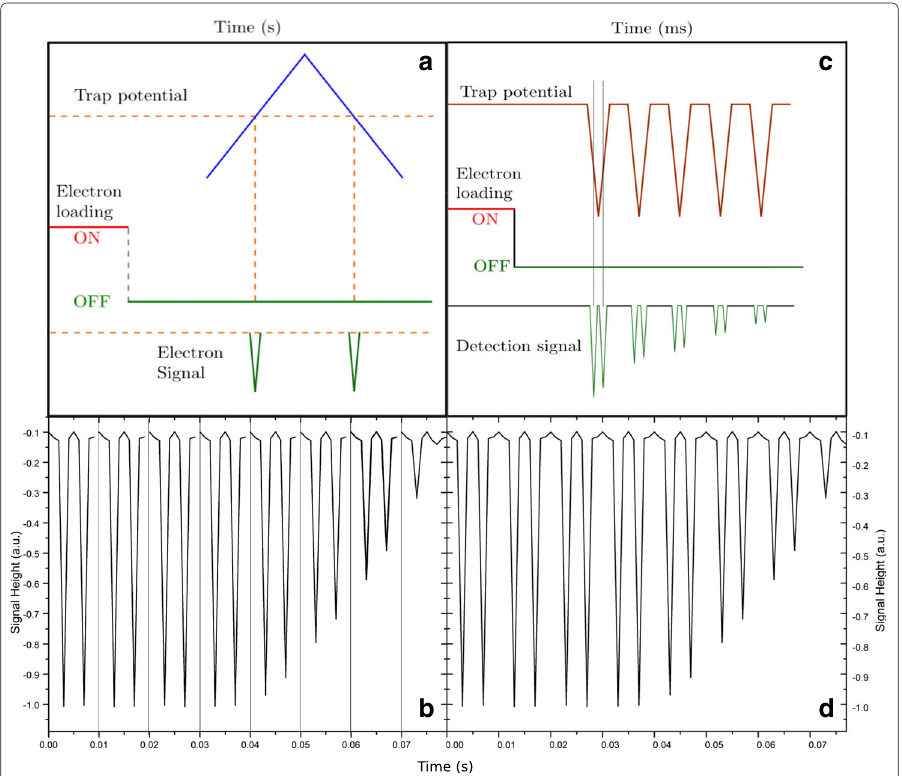
Fig. 3 ( a ) Schematic diagram of single ramp scanning mode ( b ) Electron signal fall-off with single ramp yields τ = 72.89 ms at a magnetic field of 0.05 T ( c ) Schematic diagram of continuous ramps scanning mode ( d ) Electron signal fall-off with time for continuous ramping yields τ = 72.32 ms at a magnetic field of 0.05